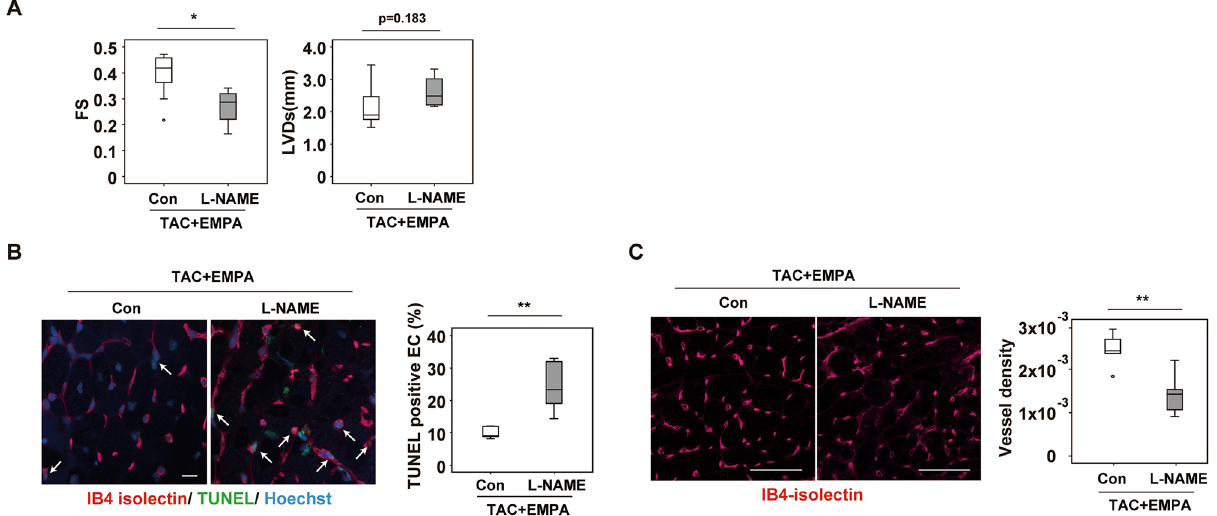
Figure 5. Effects of L-NAME administration. ( A ) Echocardiographic data analyzing fractional shortening (FS) or left ventricular systolic dimension (LVDs) of mice subjected to TAC + EMPA with or without L-NAME administration (n = 10, 4). ( B ) TUNEL (terminal deoxynucleotidal transferase–mediated biotin–deoxyuridine triphosphate nick-end labeling) of cardiac tissues of mice subjected to TAC + EMPA with or without L-NAME administration (arrow indicates TUNEL-positive ECs, scale bar = 10 μm) (right panel indicates quantification of TUNEL positive ECs (n = 6, 10)) ( C ) Immunofluorescence study for IB4-isolectin in cardiac tissues of indicated mice. Right panels indicates quantified data demonstrated as vessel density (estimated as the number of microvessels relative to the number of cardiomyocytes/cross sectional area (CSA) (μm 2 )) (n = 5, 10. scale bar = 100 μm). Data were analyzed by a 2-tailed Student’s t test ( A – C ). * P < 0.05, ** P < 0.01. Values are shown as the mean ±